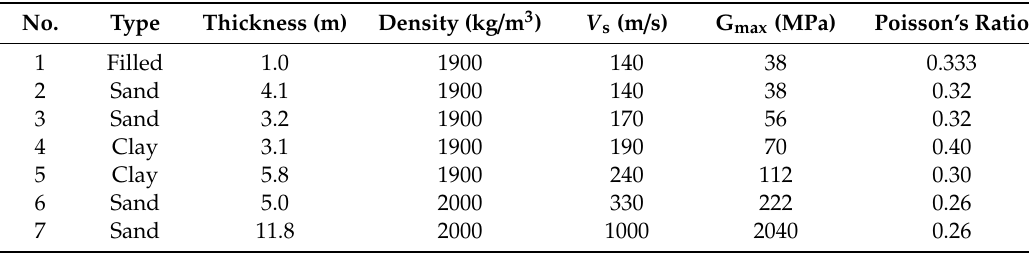
Table 1. Soil profile of Daikai station.